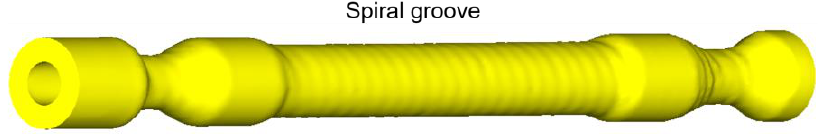
Figure 3. Spiral groove. Figure 3. Spiral